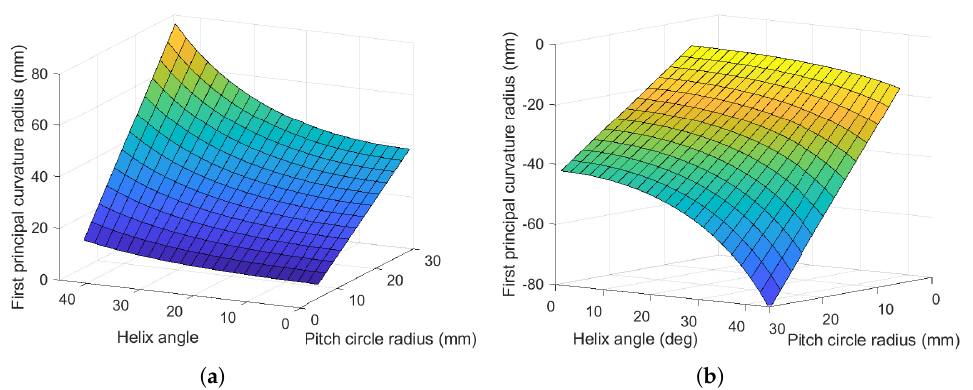
Figure 5. First principal curvature radius of the ( a ) screw shaft and ( b ) nut grooves depending on the pitch circle radius and the helix angle, for a ball screw with r b = 1.5875 mm, f s = 0.528, ϕ = 45 deg, H = 0.0629 mm and L = 0.0505 mm.